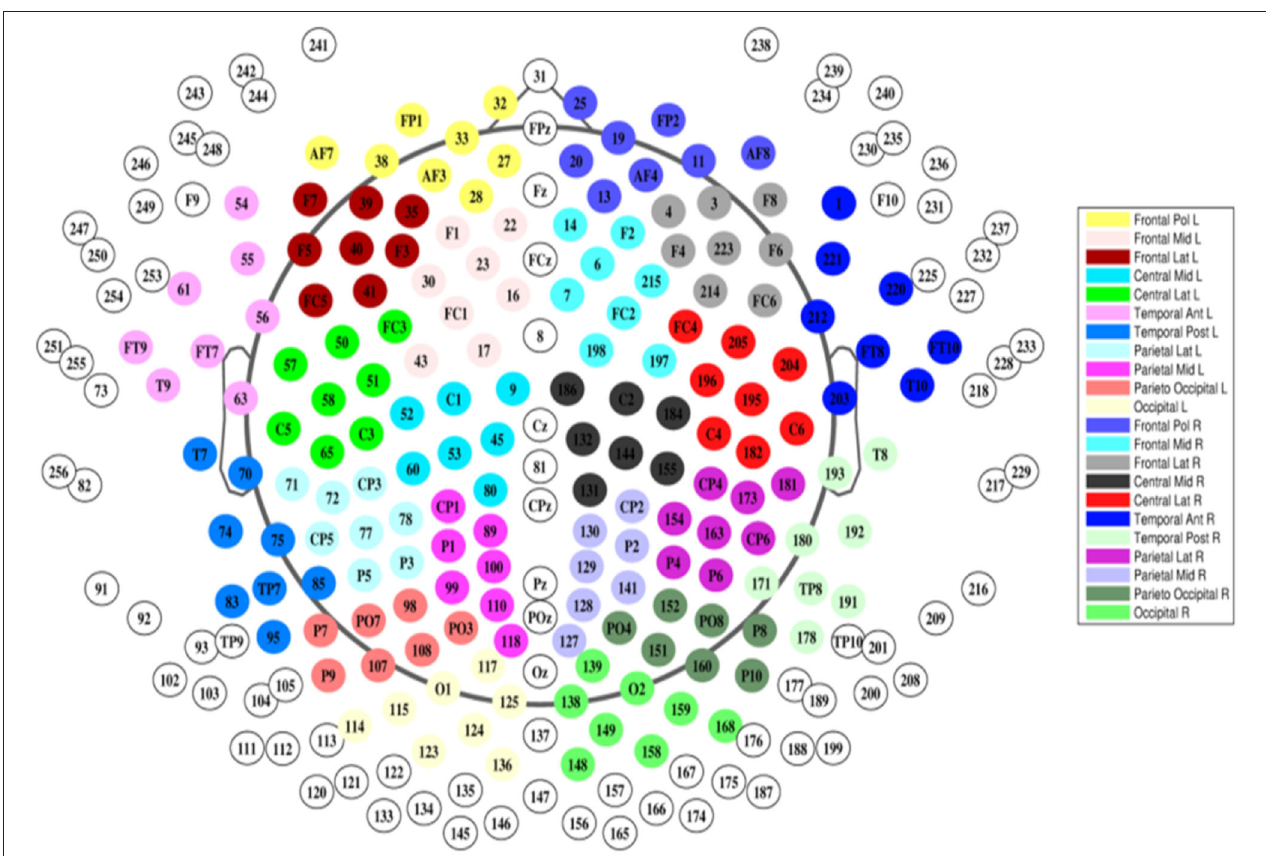
FIGURE 1 | Our electrodes were grouped according to the topographical localization of the channels and then divided into 22 non-overlapping regions of interest corresponding to the frontal, central, temporal, parietal and occipital areas (bilaterally) (Hatz et al., 2017).